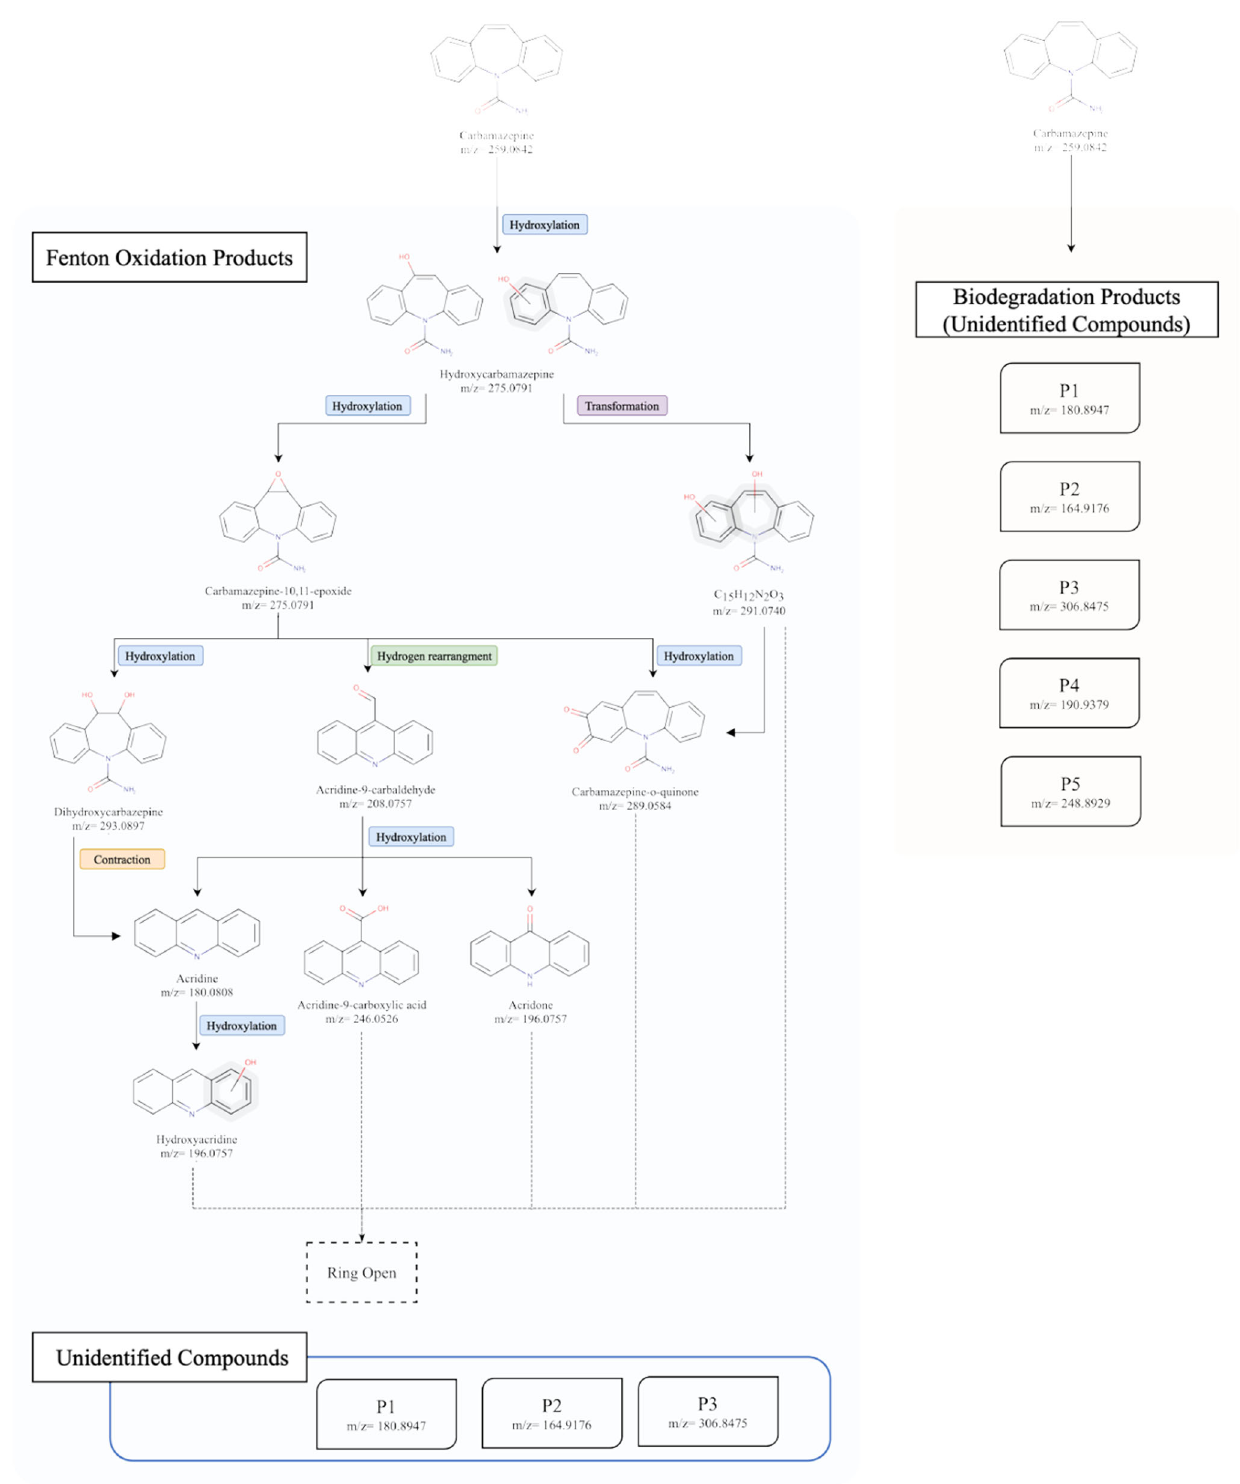
Fig. 6 Proposed degradation pathway of CBZ by the combined system. The oxidation pathway with known chemical structures is displayed on the left of the fi gure; the unidenti fi ed products generated by biological and oxidation processes are shown on the right and bottom of the fi